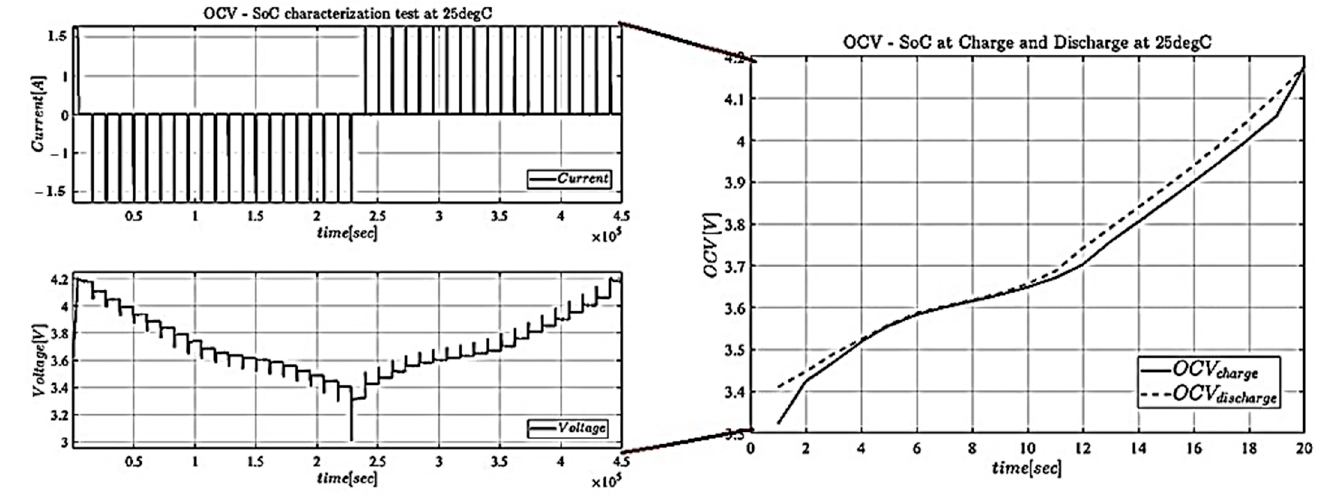
Figure 4. Implemented OCV test to the 3Ah NMC Li-ion battery at 25 °C.